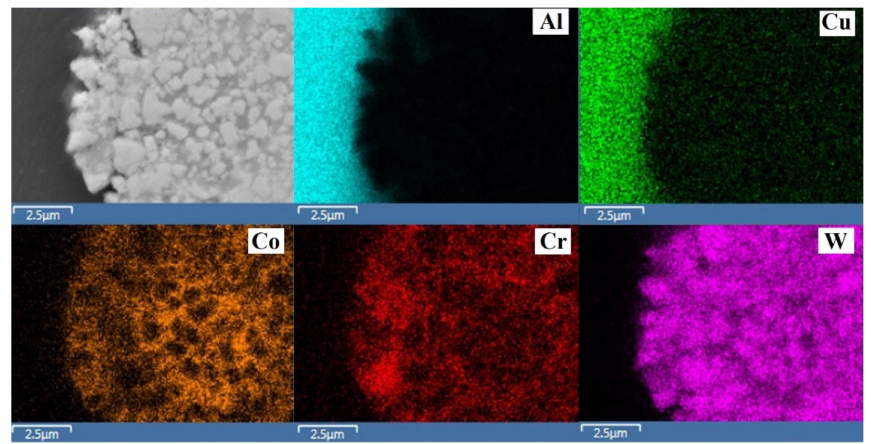
Figure 8. The results of mapping coverage (according to XRMA) on sample of batch 1.